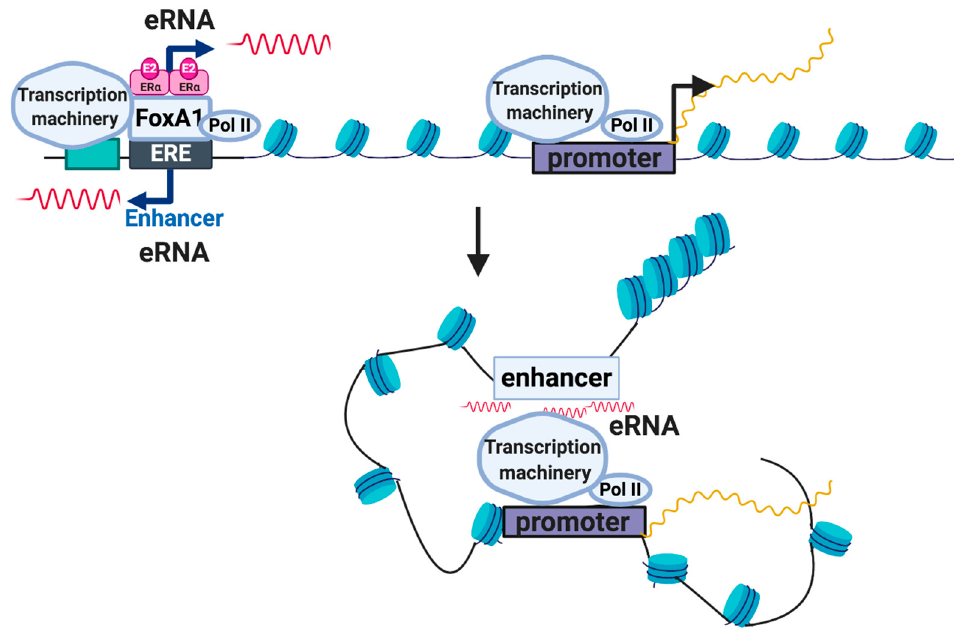
Figure 3. A plausible mechanism of estrogen-induced enhancer RNA (eRNA) function in chromatin looping. Table 1. Estrogen-regulated eRNAs.